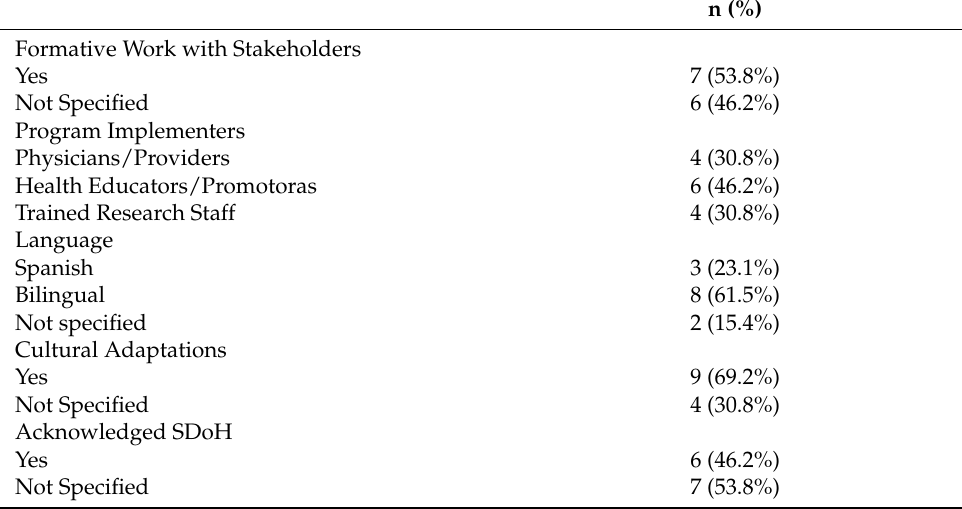
Table 3. SDoH integrated and stakeholder collaboration in interventions (n =